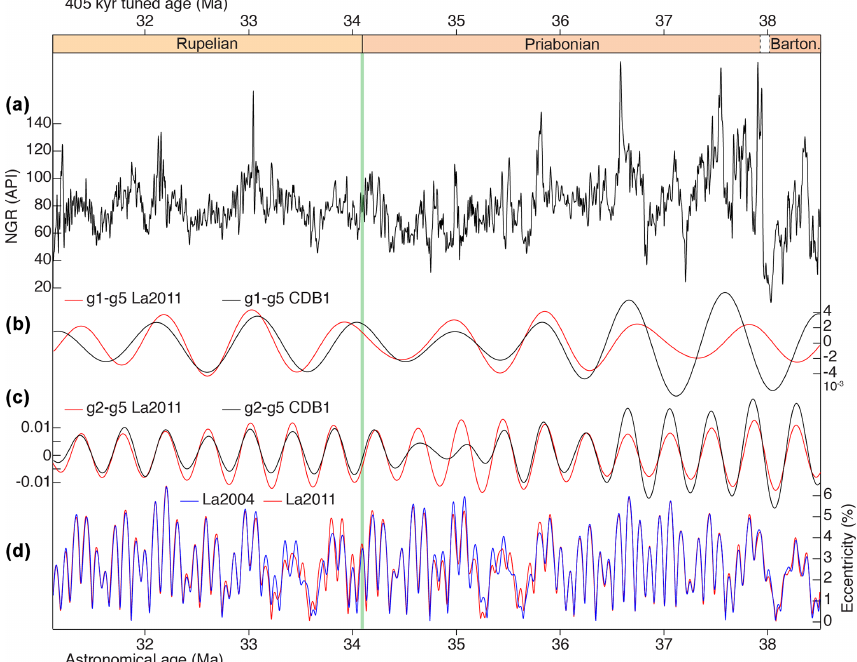
Figure 5. Astronomical calibration of CDB1 core, along with filtering at 405kyr (g2–g5) and ∼ 1Myr (g1–g5) bands. (a) NGR data are tuned to a single 405kyr sinusoid function and then anchored at the Eocene–Oligocene boundary at 34.10Ma. The 34.10Ma is the age showing the best phase relationship between the tuned NGR and La2004 orbital eccentricity curve (Laskar et al., 2004) at the 405kyr cyclicity (Fig. S9; see Sect. 4.1 for detail). (b) Band-pass filtering at ∼ 1Myr band. (c) Band-pass filtering at 400kyr band. (d) Raw La2004 and La2011 orbital eccentricity data (Laskar et al., 2004, 2011).